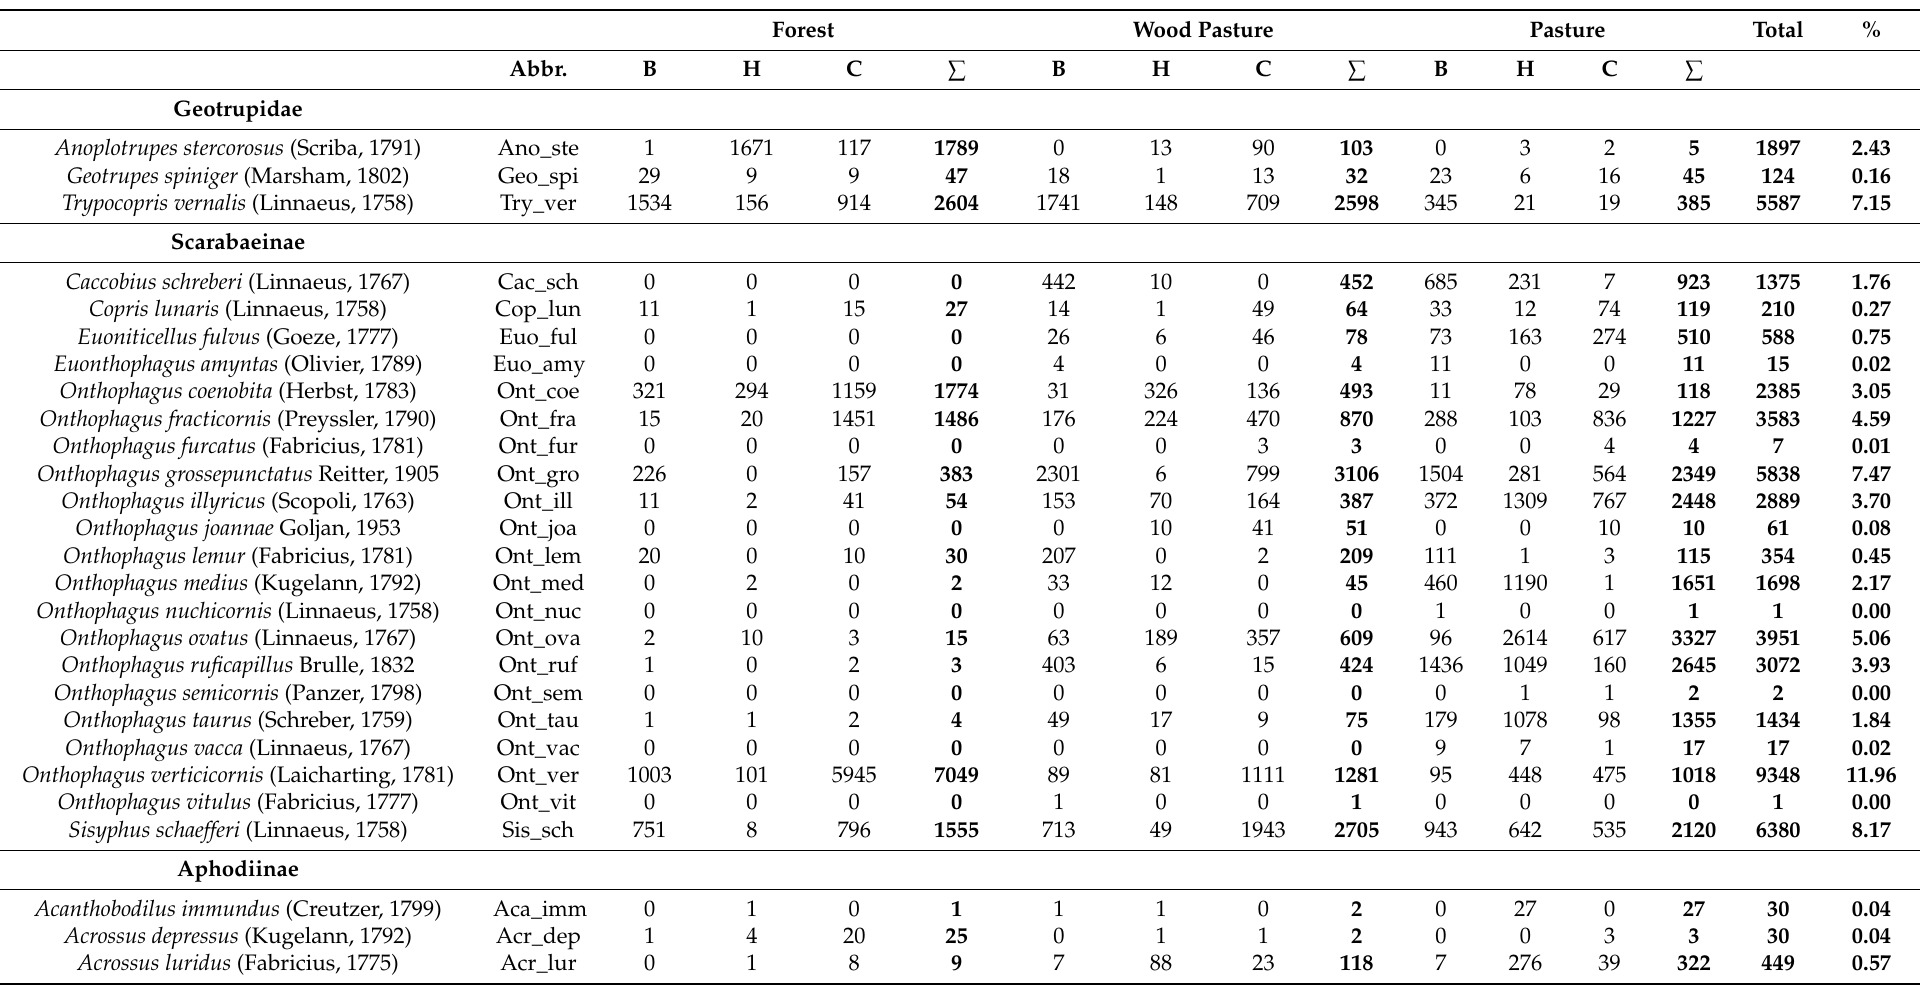
Table A1. List of dung beetle species, and their abundances according to habitats at the three regions in Hungary (B—Balatonakali, H—Holl ó k˝o, C—Cser é